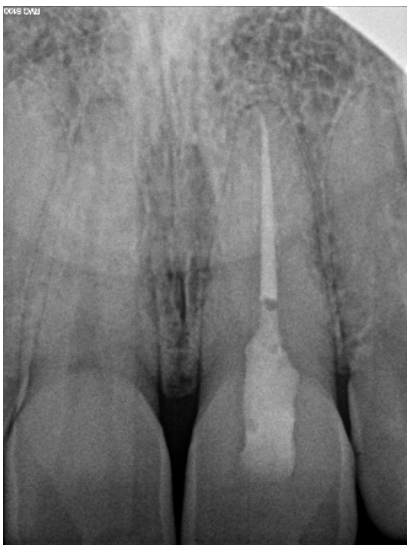
Figure 18. X-ray image showing the correctness of the performed root canal